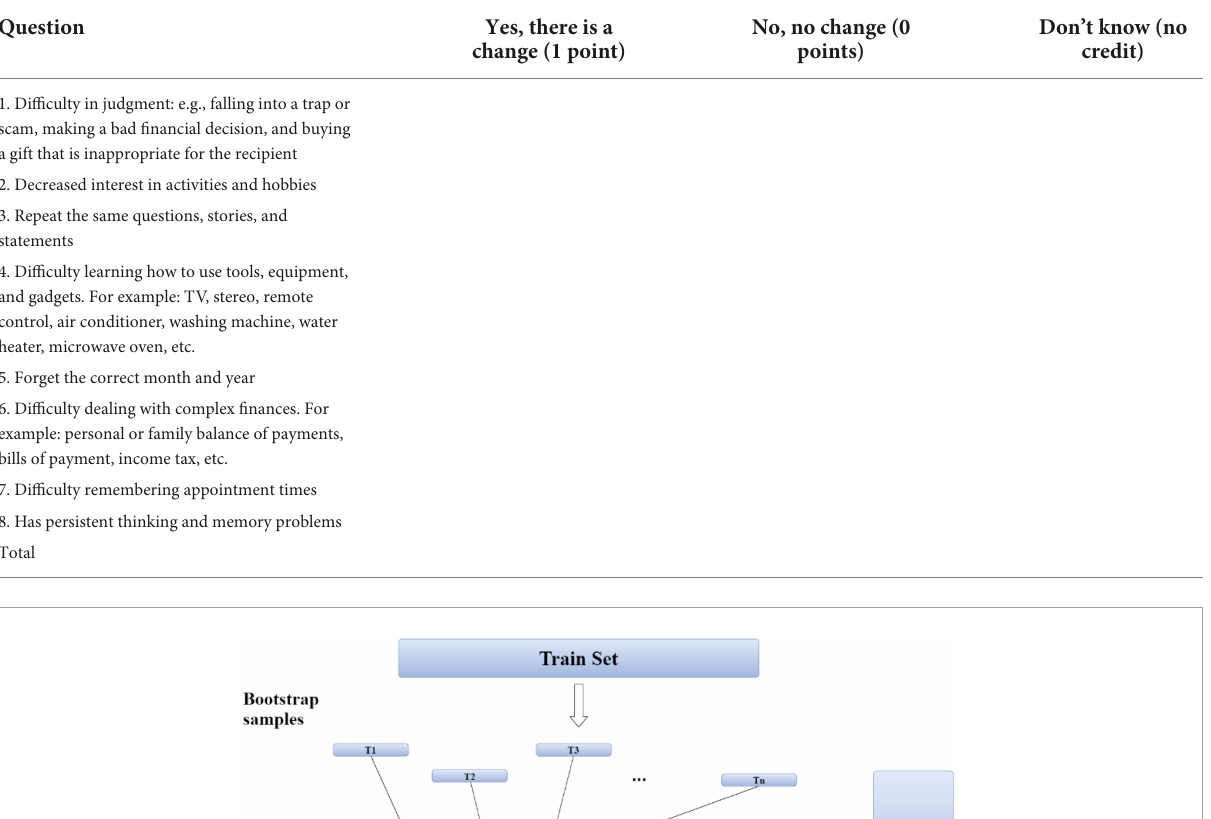
TABLE 2 The problems of the AD-8 scale.